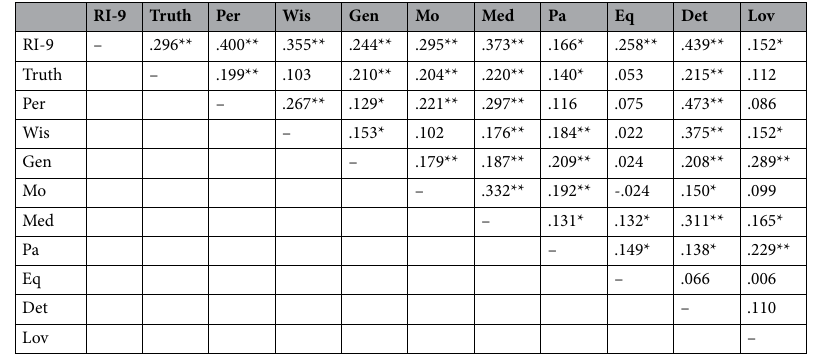
Table 4. Spearman rank correlation between RI-9 and each inner strength. Truth = Truthfulness, Per = Perseverance, Wis = Wisdom, Gen = Generosity, Mo = Morality, Med = Meditation, Pa = patience (tolerance), Eq = Equation, Det = Determination, Lov = Loving-Kindness.